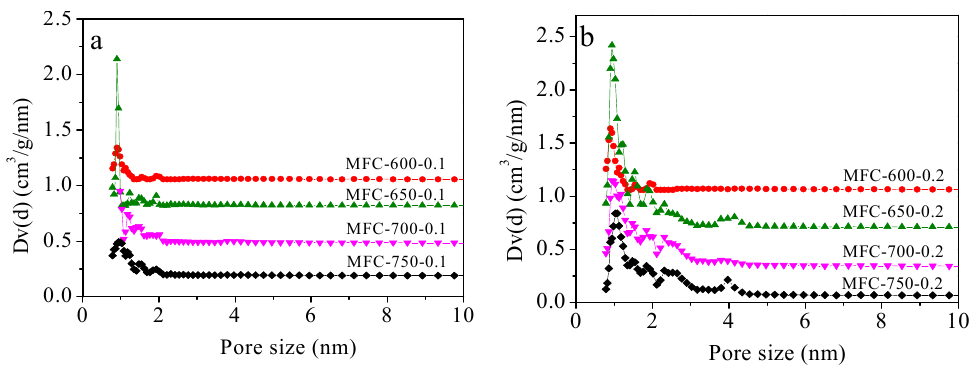
Figure 4. Pore size distribution of the samples prepared at KOH/MF ratio of ( a ) 0.1 and ( b ) 0.2. Dv(d) = dV/dD